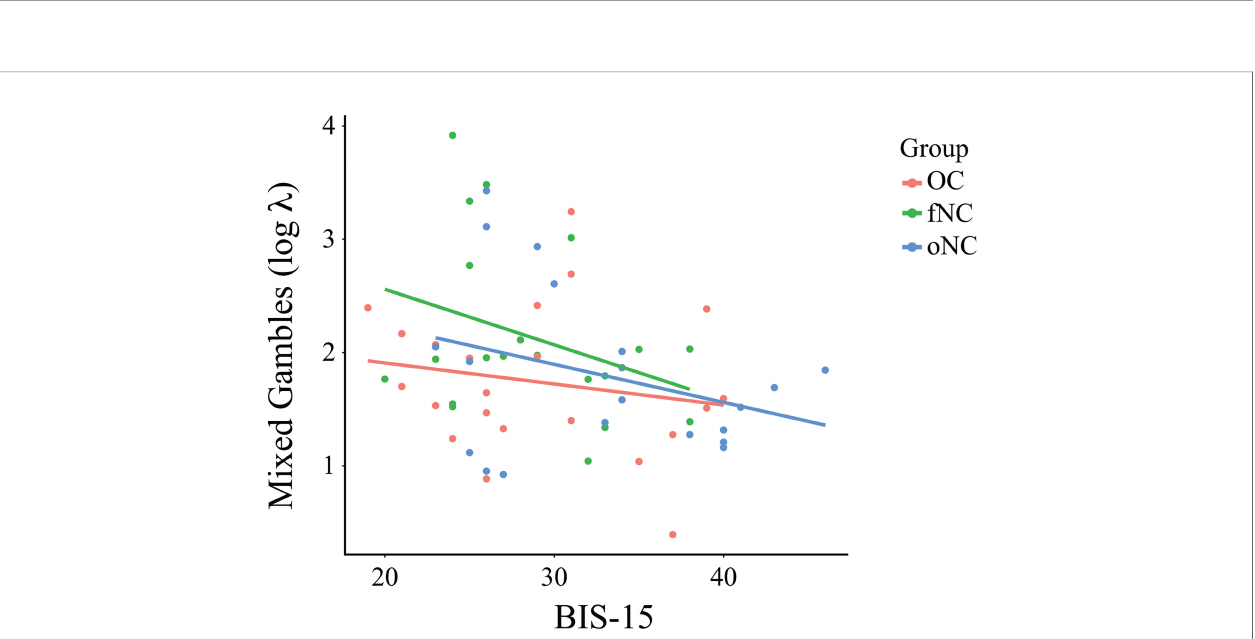
FIGURE 4 | Relationship between the parameter l (loss aversion) of the mixed gambles task and BIS-15 total score per group. BIS-15 as a covariate was signi fi cantly associated with loss aversion for all three groups, F (3,58) = 2.87, p = .044, h 2 p = : 071 Each dot represents an individual subject. OC, women using OCs; fNC, women in the early follicular phase; oNC, women during periovulatory